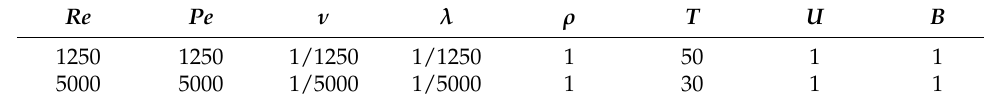
Table 1. Parameters for different cases.